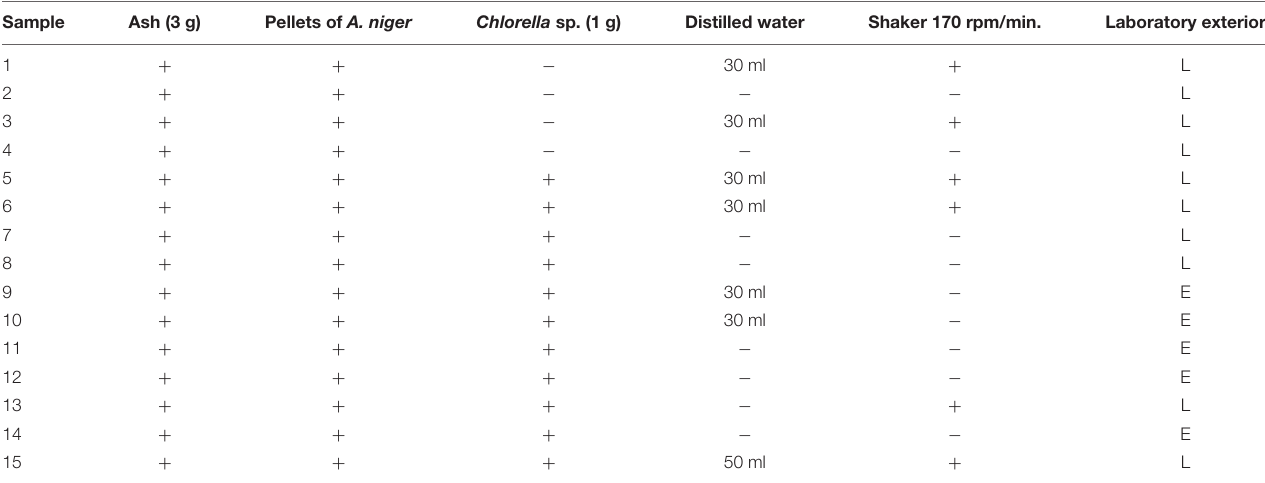
FIGURE 3 | (A) Aspergillus niger pellets after application to the ash substrate under laboratory conditions on a shaker and without addition of water. (B) Detail of the Aspergillus niger pellet with Chlorella sp. and with nickel particles. (C,D) Detail of the “hairy region” of the Aspergillus niger pellet with Chlorella sp.. (E) Detail of “hairy region” with the conidial head of Aspergillus niger . TABLE 2 | Conditions of all experiments in laboratory or in the exterior.